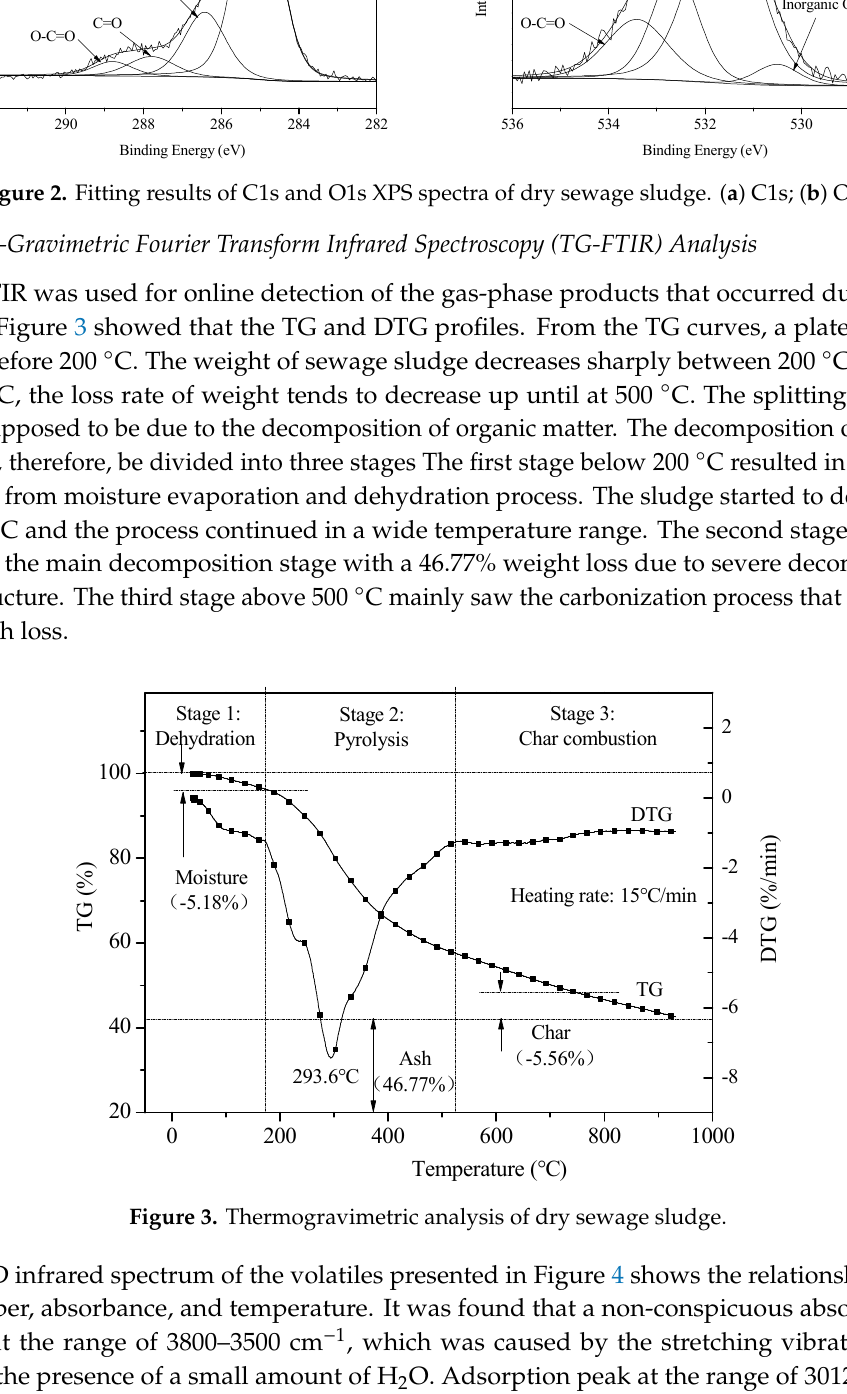
Figure 3. Thermogravimetric analysis of dry sewage sludge.